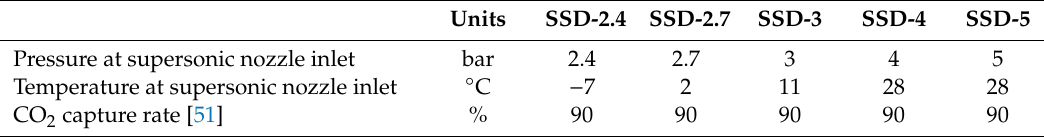
Table 8. List of the Supersonic Flow Driven CO 2 Anti-Sublimation and Inertial Separation (SSD) cases